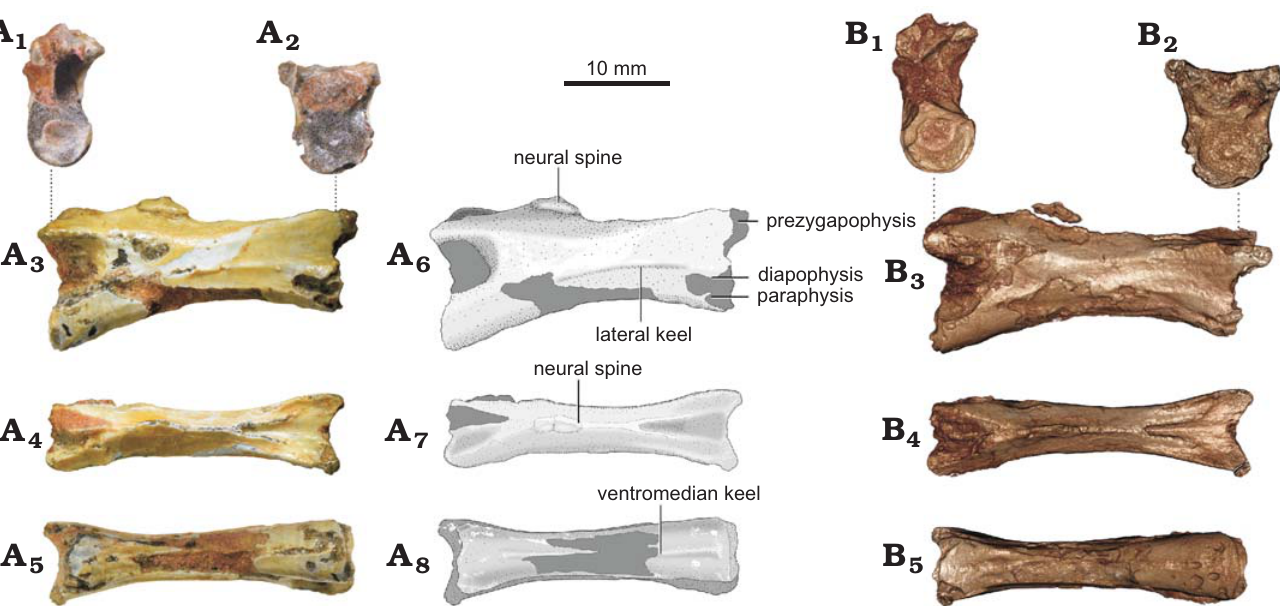
Fig. 2. Cervical vertebra (UFRGS-PV-492-T) of of ?Tanystropheidae indet. from Sanga do Cabral Formation (Induan–early Olenekian). A . Photographs (A 1 –A 5 ) and explanatory drawings (A 6 –A 8 ). B . Virtual 3D reconstructions (see SOM 2). In posterior (A 1 , B 1 ), anterior (A 2 , B 2 ), right lateral (A 3 , A 6 , B 3 ), dorsal (A 4 , A 7 , B 4 ), and ventral (A 5 , A 8 , B 5 )